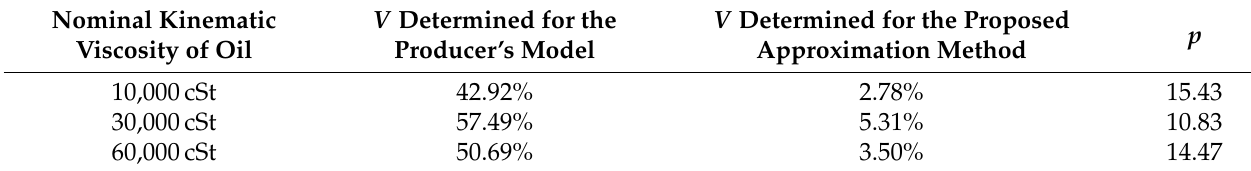
Table 3. Values of the coefficient of residual variation V .